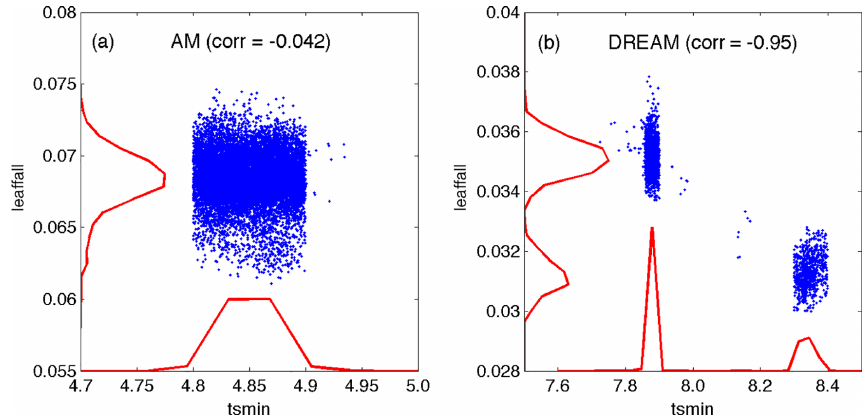
Figure 5. Posterior distributions of parameters tsmin and leaffall simulated by (a) AM and (b) DREAM. AM simulation results exhibit a negligible correlation coefficient (corr) between the two parameters with a value of − 0 . 042, while DREAM results show that the two parameters are strongly correlated with the corr value of − 0 . 95.